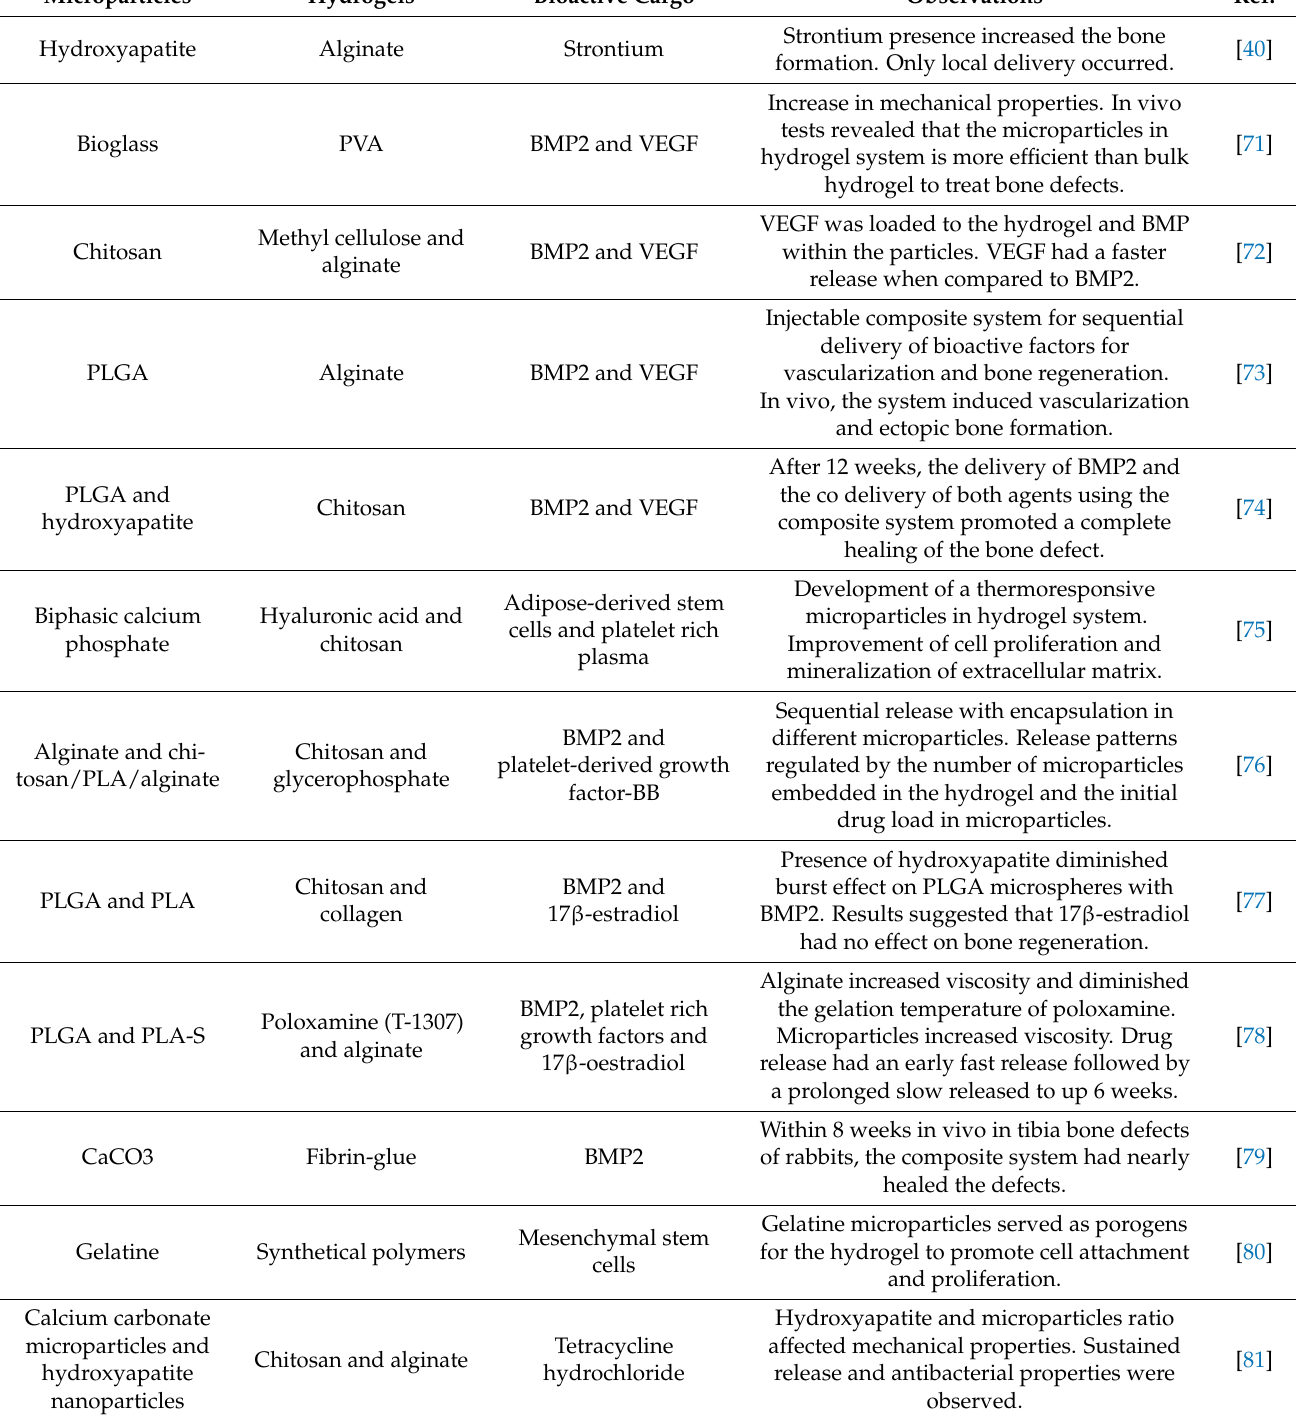
Table 5. Microparticles in hydrogel system for bone diseases